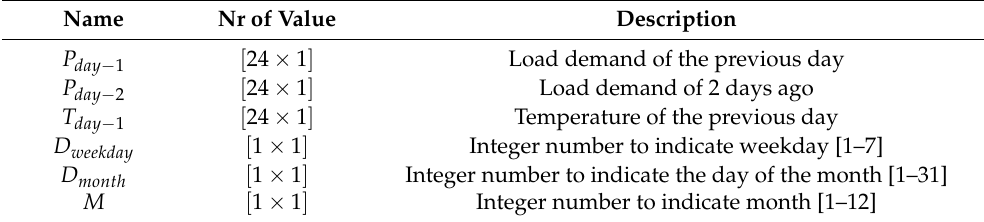
Table 3. Neural network input